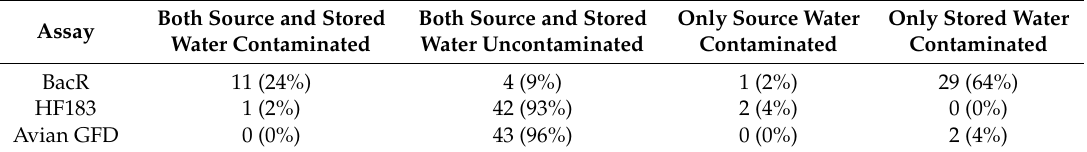
Table 4. MST molecular marker detection in paired source and stored water samples ( n = 45 households). Households returning the same result for both samples have concordant pairs, whereas those with only one of their water samples showing contamination have discordant